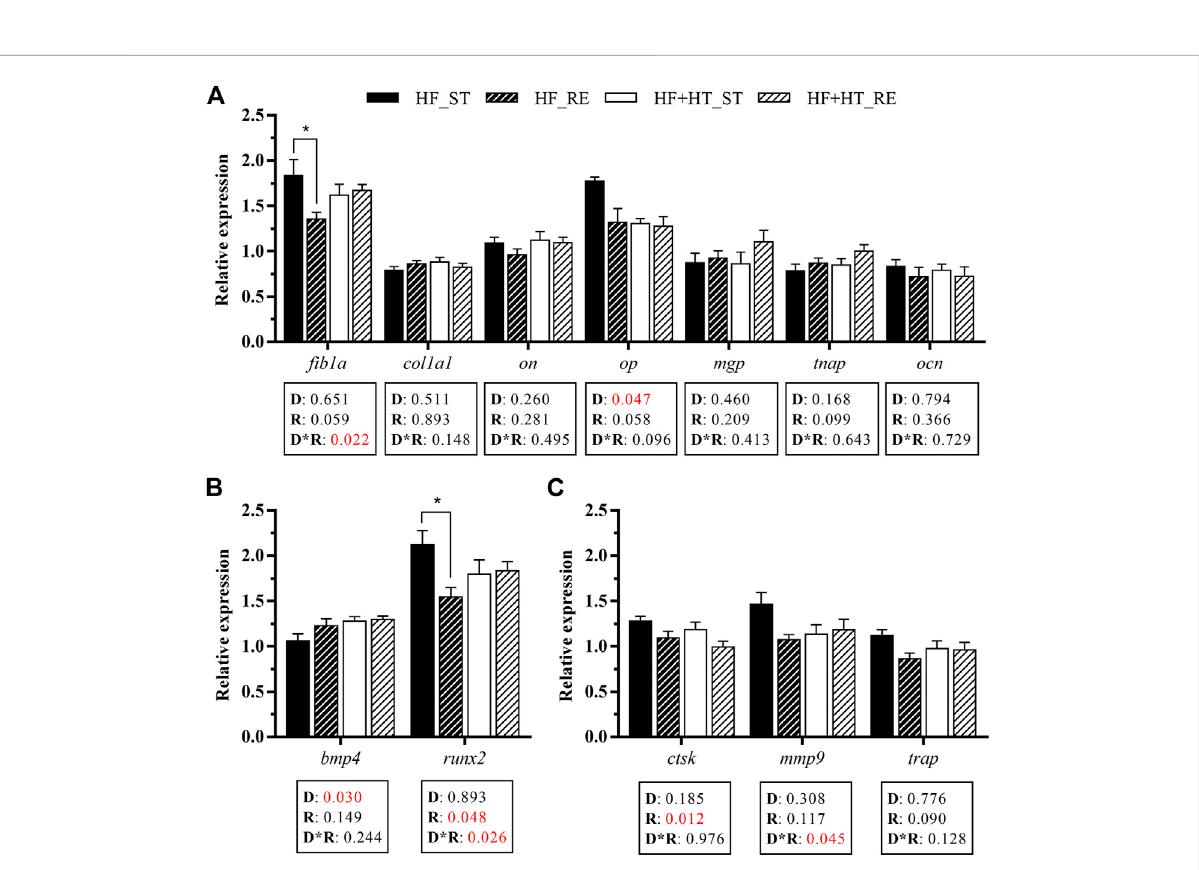
FIGURE 5 Relative gene expression of (A) extracellular matrix components, (B) osteogenic and (C) osteoclastic markers in bone of gilthead sea bream juvenilesfedwithahigh-fatdietintheabsence(HF)orpresence(HF+HT)ofhydroxytyrosol(0.52 gHT/kgfeed),atastandard(ST)(3%biomass/tank) or restricted ration (RE) (40% daily reduction) for 8 weeks. Data are shown as Mean +SEM ( n = 10). Statistical differences are indicated in 3components:diet(D),ration(R)andinteraction(D*R),usingtwo-wayANOVA( p < 0.05,showedinred).Whentheinteractionbetweenthetwo factors (D*R) was signi fi cant, comparisons among groups were analyzed by a Tukey ’ s post-hoc test and, signi fi cant differences among groups are indicated by asterisks ( p <